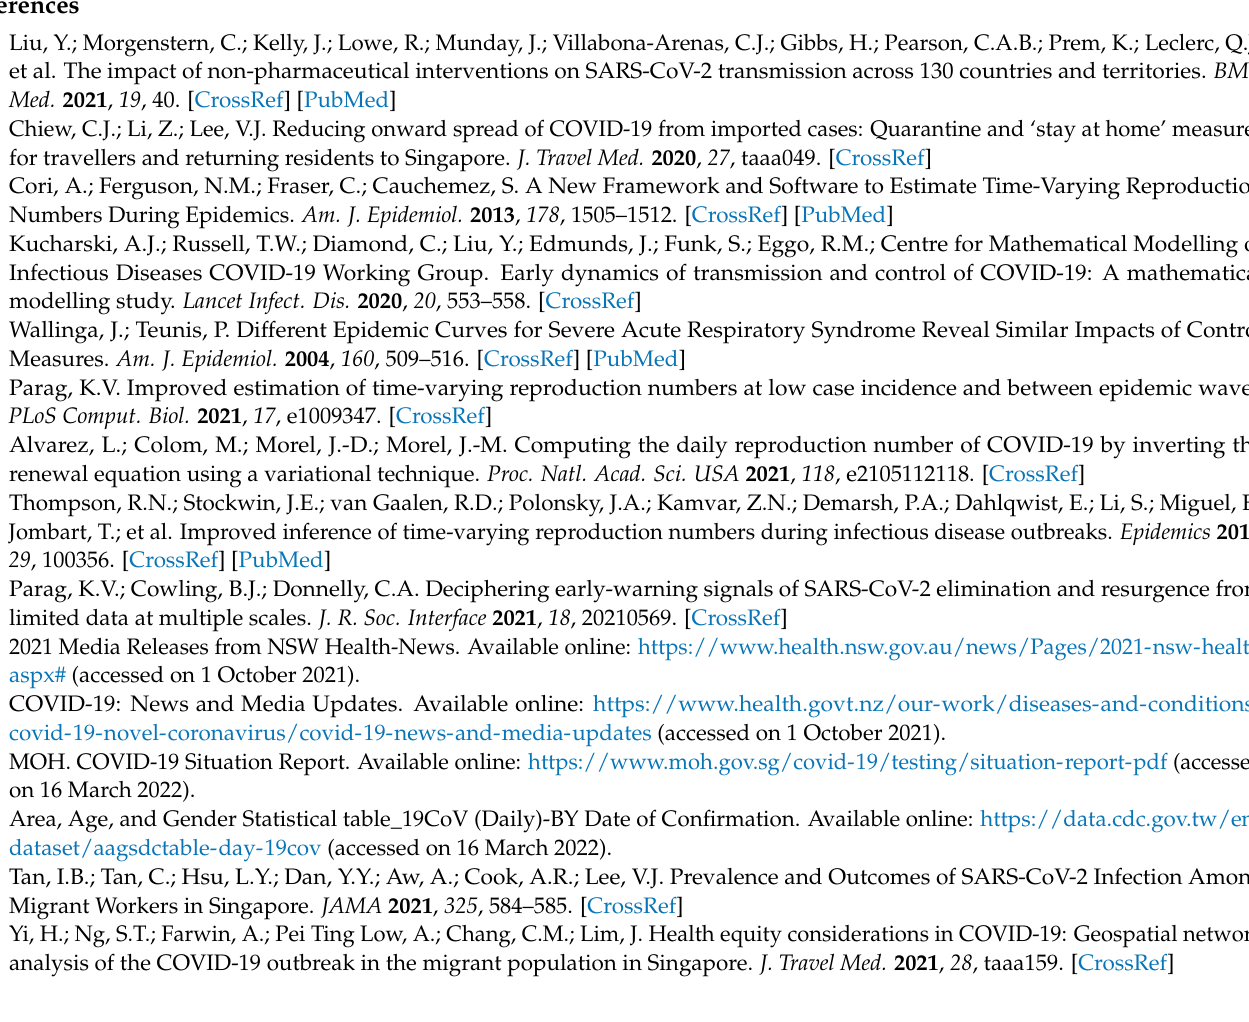
from 157 pairs of household infections in Singapore. Figure S4: Comparison of R t estimates by EpiRegress, EpiEstim, EpiFilter and EpiInvert against the true values for the four different incidence curves in scenario 1. Figure S5: Comparison of R t estimates by EpiRegress, EpiEstim, EpiFilter and EpiInvert against the true values for the four different incidence curves in scenario 1. Figure S6: Comparison of the reported and estimated local case counts. Figure S7: Comparison of point estimates of R t based on three different regression models. Figure S8: Comparison of estimates in scenarios when phase factors were or were not considered as part of the X covariates for Singapore. Figure S9: comparison of R t estimates in scenarios when dormitory cases were or were not regarded as part of the imported case counts for